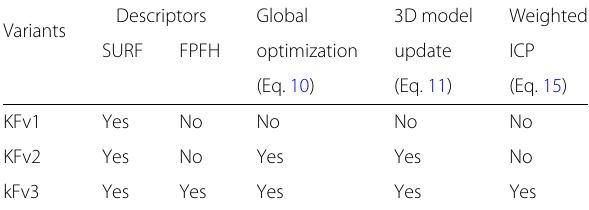
Table 2 Evaluation of our proposal considering the